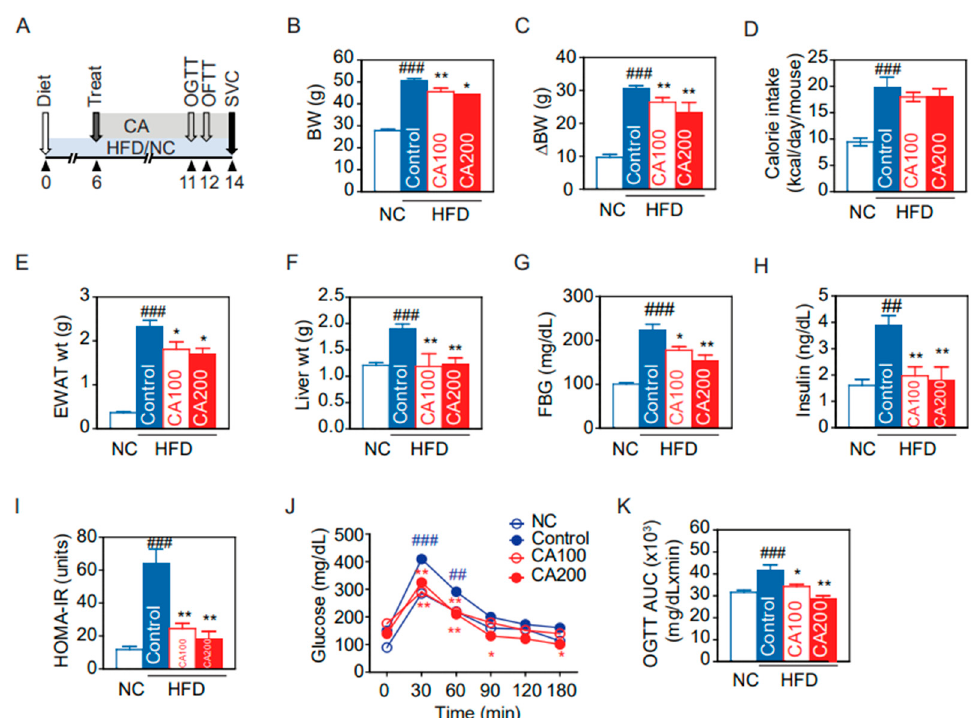
Figure 2. Changes of glucose and metabolic profiles by CA in HFD mice: ( A ) experimental scheme, ( B ) body weight (BW) at the end of the experiment, ( C ) changes of BW, ( D ) oral calories intake, ( E ) epididymal white adipose tissue (EWAT) weight, ( F ) liver weight, ( G ) fasting blood glucose (FBG), ( H ) fasting insulin, ( I ) homeostatic model assessment of insulin resistance (HOMA-IR), ( J ) time-course changes of blood glucose in oral glucose tolerance test (OGTT), and ( K ) area under the curve (AUC) of OGTT. Data are expressed as the mean ± SEM ( n = 5). ## p < 0.01, ### p < 0.001 vs. NC, and * p < 0.05, and ** p < 0.01 vs. HFD-control. NC, normal chow; Control, HFD-control; CA100, HFD plus CA 100 mg/kg; CA200, HFD plus CA 200 mg/kg.